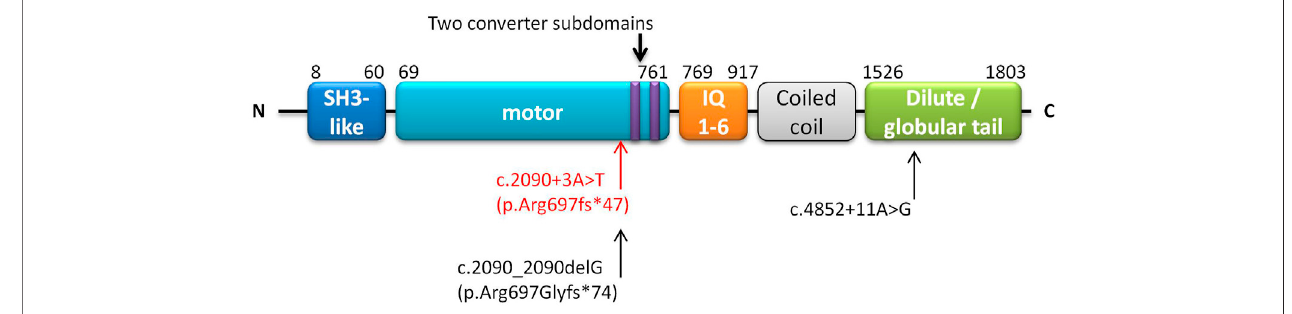
FIGURE 1 | Schematic of domains of the MYO5B gene. The annotation is based on UniProt (https://www.uniprot.org/uniprot/Q9ULV0). The homozygous NM_ 001080467.2:c.2090+3A > T(p.Arg697fs*47)foundinthisstudyismarkedinred.Anotherpatientharboredc.2090_2090delG(p.Arg697Glyfs*74)(closetoourreported variant), along with c.4852 + 11A > G which is marked in black (Qiu et al.,